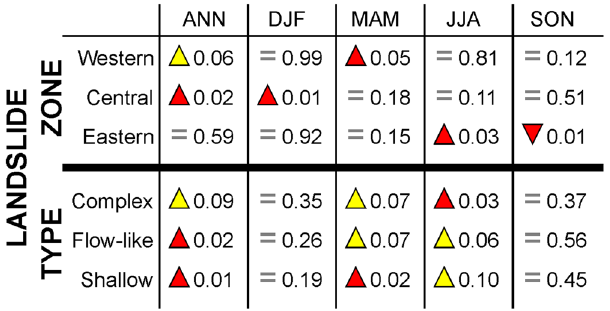
Figure 4. P-values of Mann-Whitney U test showing differences between years with and without landslide activity based on annual (ANN) and seasonal (DJF = winter; MAM = spring; JJA = summer; SON = autumn) precipitation totals, regions and landslide types. Red up = significantly higher precipitation during event years; yellow up = higher precipitation, but no significant difference: 0.05 < p < 0.10; equal sign = no significant difference; red down = significantly lower precipitation sums in event